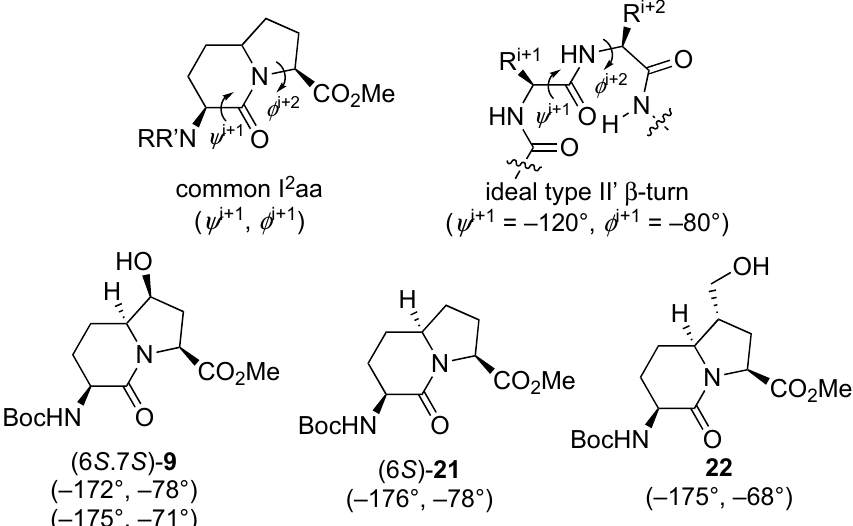
Figure 4. X-ray-determined backbone dihedral angles of related I 2 aa systems and an ideal type II ′ β -turn [11,44,45].